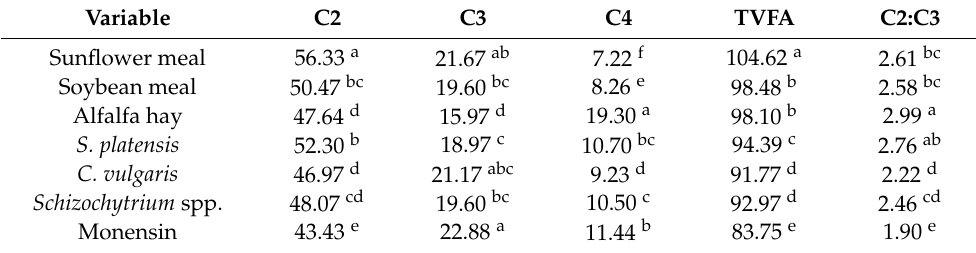
Table 2. The parameters of in vitro rumen fermentation of the tested substrates regarding molar proportions of acetate (C2), propionate (C3), butyrate (C4), total VFA concentrations (TVFA, mmol/L), and the ratio of acetate to propionate (C2:C3). Variable C2 C3 C4 TVFA